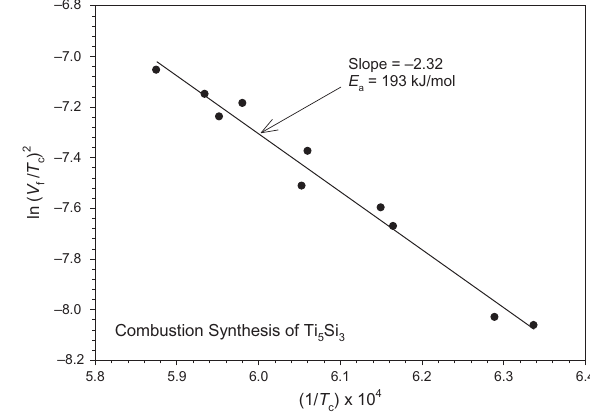
Figure 2: Effects of sample compaction density on flame-front velocity and combustion temperature of elemental powder compacts of Ti:Si ¼ 5:3.